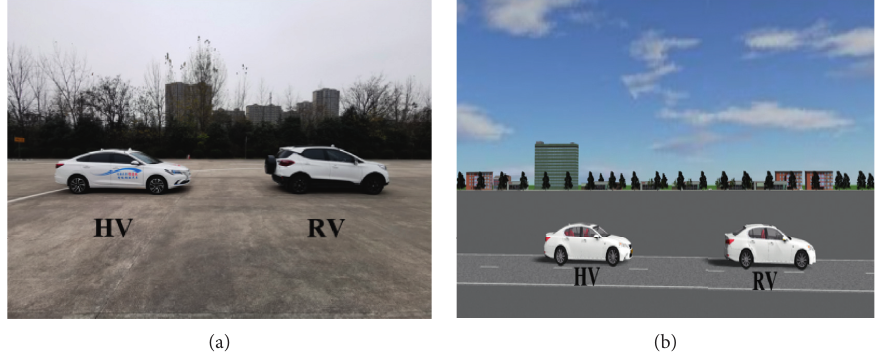
Figure 9: Car-following scenario. (a) Actual test scenario. (b) Simulation test